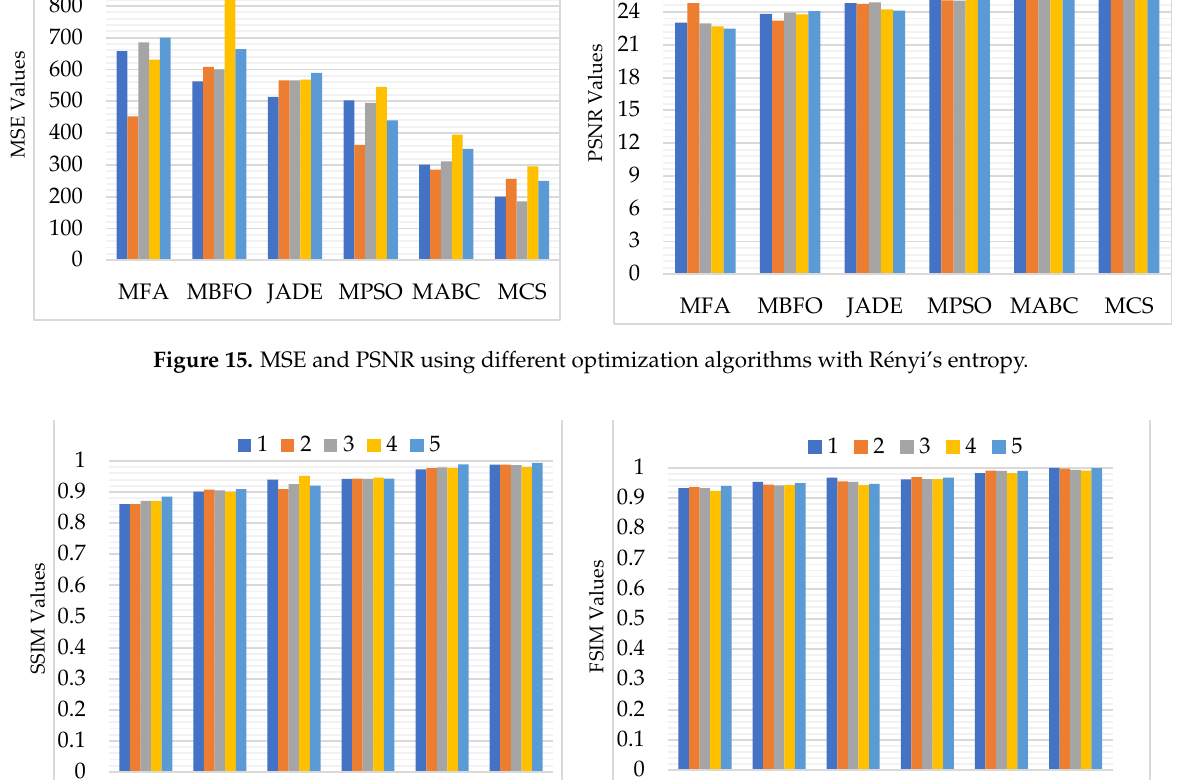
Figure 16. SSIM and FSIM computed by different algorithms using Rényi’s entropy.